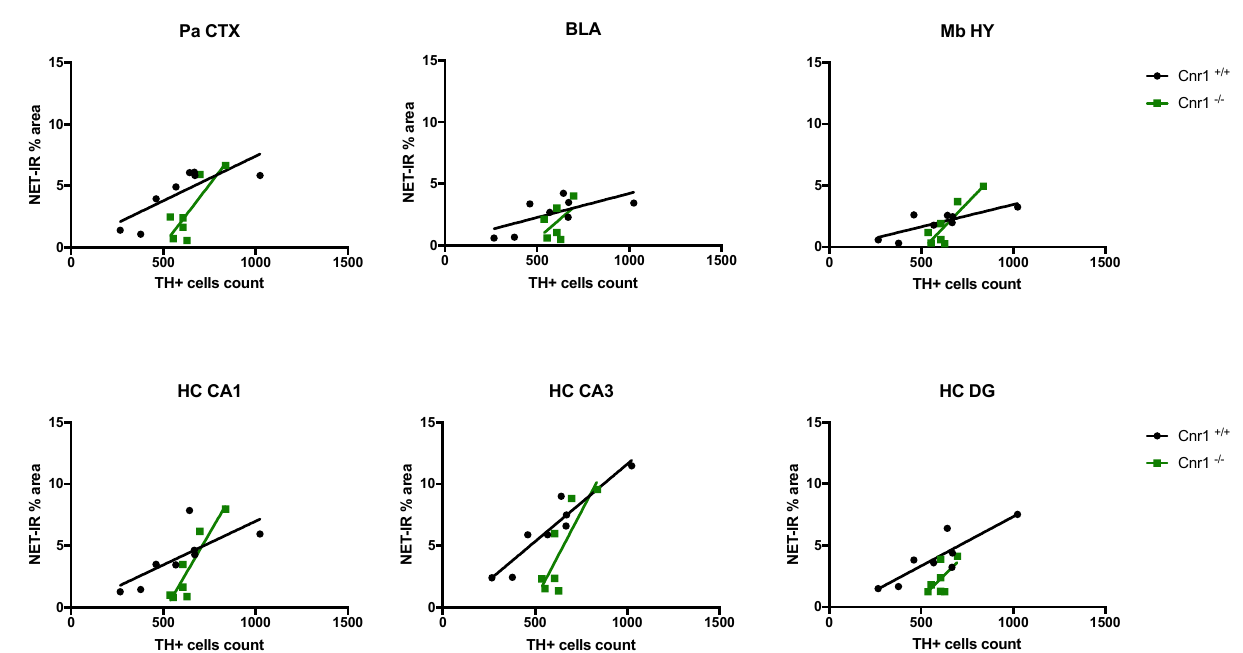
Figure 5. Correlation analysis between the number of tyrosine hydroxylase (TH)-positive cells and the NET signal intensity parietal cortex (Pa CTX), basolateral amygdala (BLA), mediobasal hypothalamus (Mb HY) and hippocampal cornu ammonis 1 (HC CA1), cornu ammonis 3 (HC CA3), and dentate gyrus (HC DG) in wild-type and Cnr1 − / − mice. Table 1. Correlation analysis between the number of tyrosine hydroxylase (TH)-positive cells and the NET-positive axon densities in the parietal cortex (Pa CTX), basolateral amygdala (BLA), mediobasal hypothalamus (Mb HY) and hippocampal cornu ammonis 1 (HC CA1), cornu ammonis 3 (HC CA3), and dentate gyrus (HC DG) in wild-type and Cnr1 − / − mice. Wild-Type Cnr1 − / − Brain Area Correlation (r, Significance Spearman)